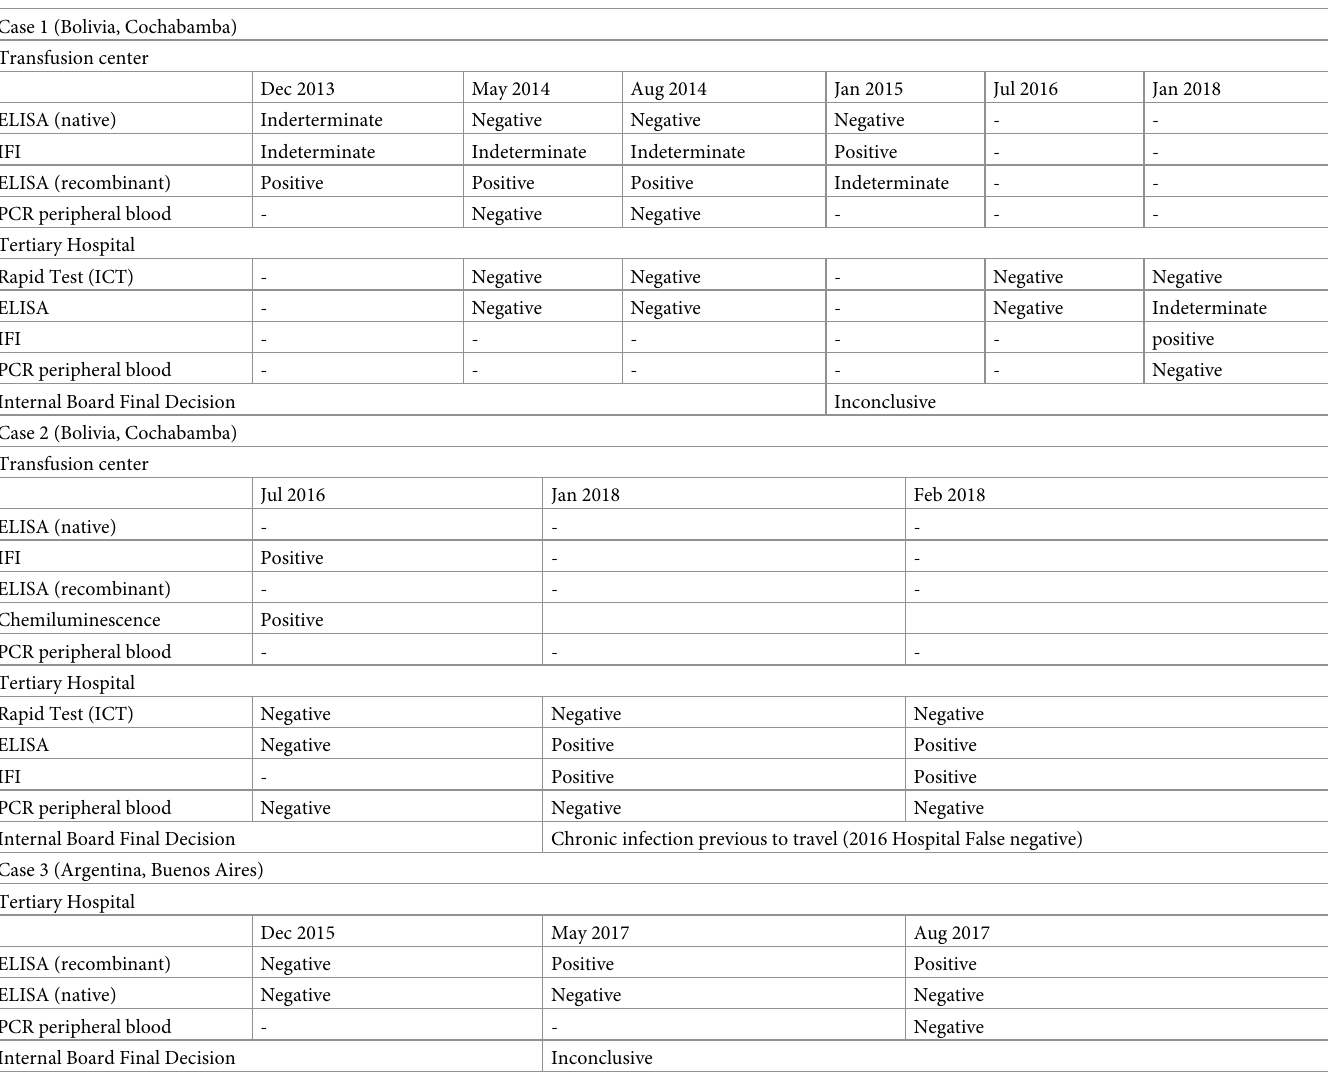
Table 4. Trace back investigation of participant with a positive serology testing and internal board final decision (shade results are before traveling to T . cruzi endemic countries). Case 1 (Bolivia,